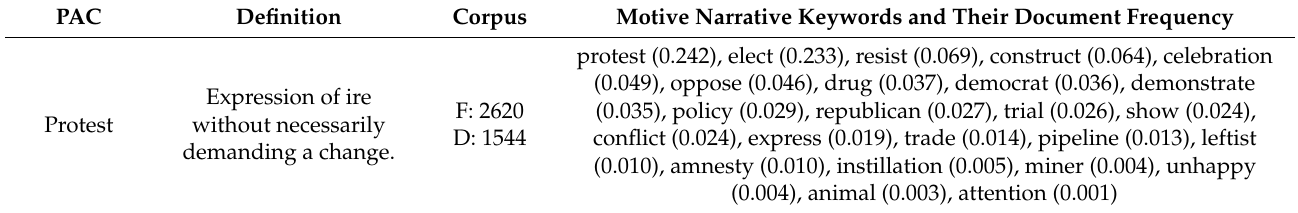
Table 2. Results of the